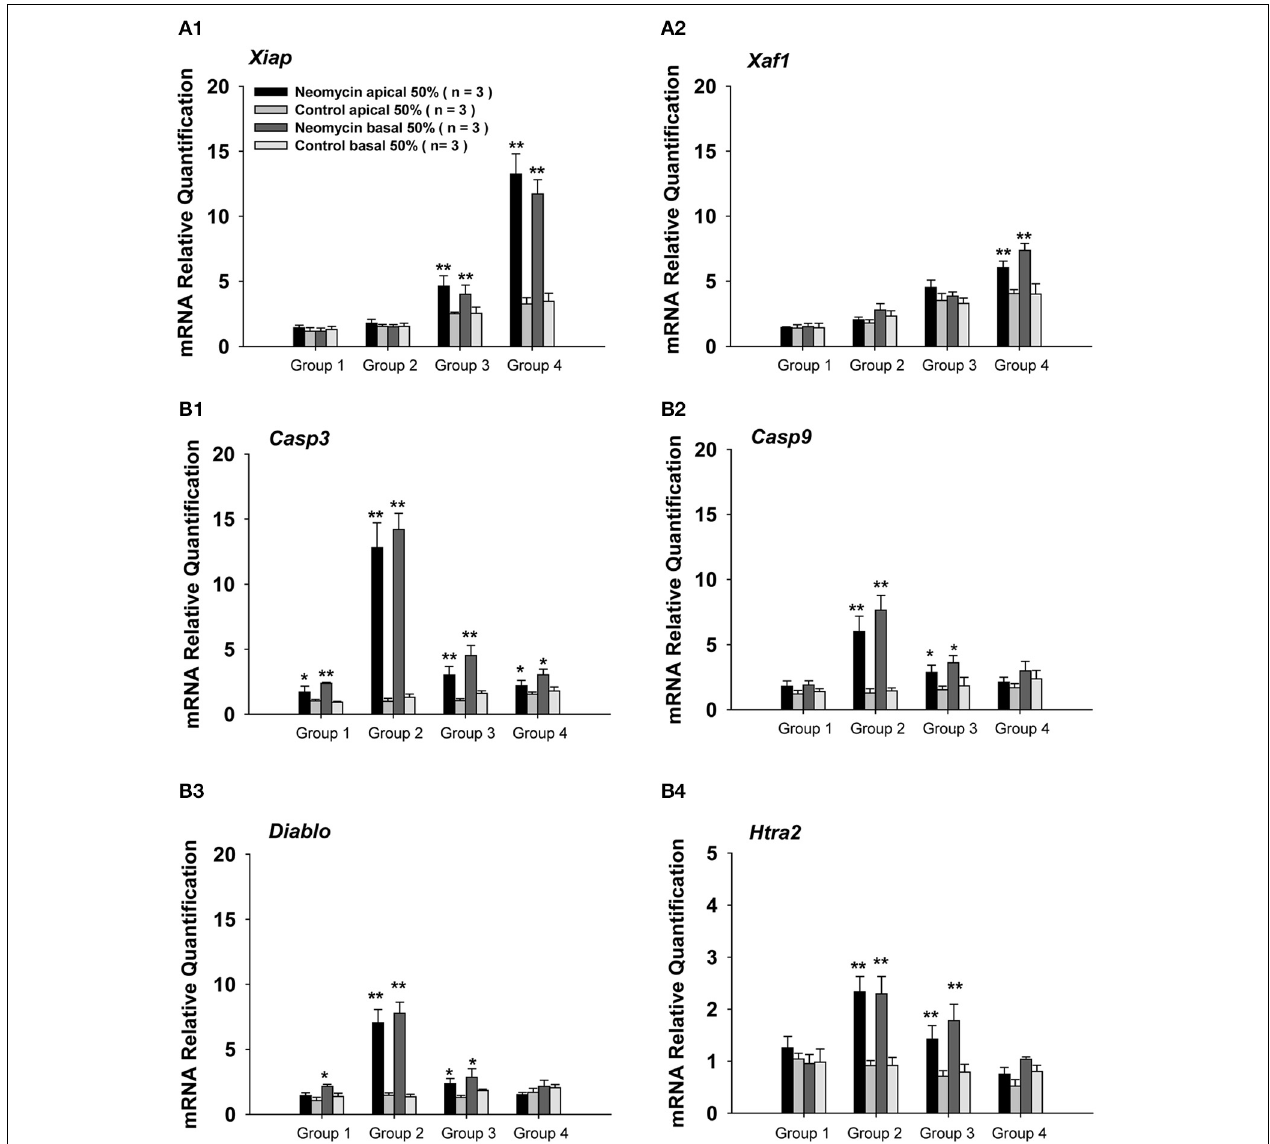
FIGURE 3 | Apoptosis-related gene expression in neomycin-treated WT mice. (A,B) mRNA expression of the anti-apoptotic genes Xiap (A1) and Xaf1 (A2) and the pro-apoptotic genes Casp3 (B1) , Casp9 (B2) , Diablo (B3) , and Htra2 (B4) in the apical 50% and basal 50% of the cochleae in WT mice